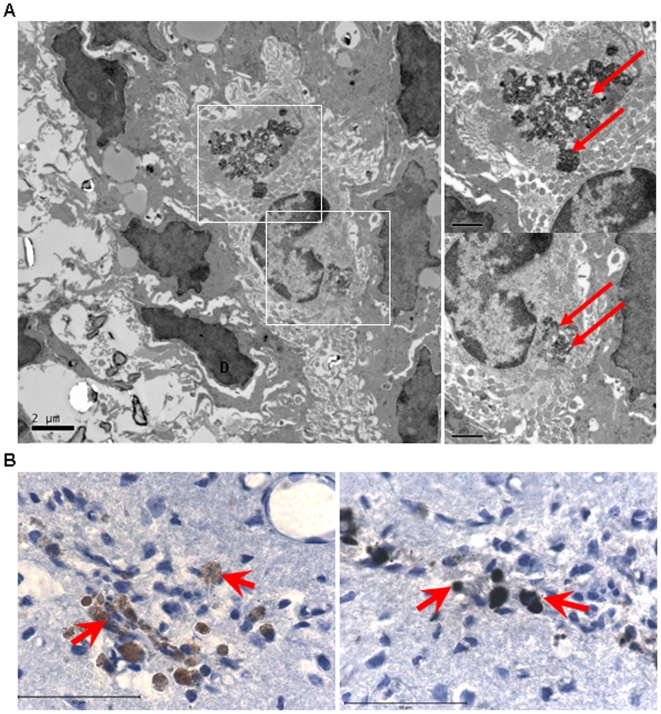
Retention of FE-Pro complex within labeled NSCs after implantation in tumor-bearing mice.(A) Electron micrograph of mouse brain that received intra-tumoral NSC administration (left). On the right are higher magnification images of the outlined areas in (A) (top and bottom). The FE-Pro complex is shown as an electron-dense iron label within the cells (solid boxes, A; red arrows, B). This is comparable to the morphology of encapsulated iron label in labeled NSCs in vitro (Fig. 2B). (B) Light microscopy images of huMito-positive cells (migrated FE-Pro-labeled NSCs and U251 cells) at the tumor site (B left, red arrows), and huMito and Prussian blue double-stained FE-Pro-labeled NSCs in parallel sections (B right, red arrows). Scale bars = 2 µm (A left), 1 µm (A right) and 50 µm (B).